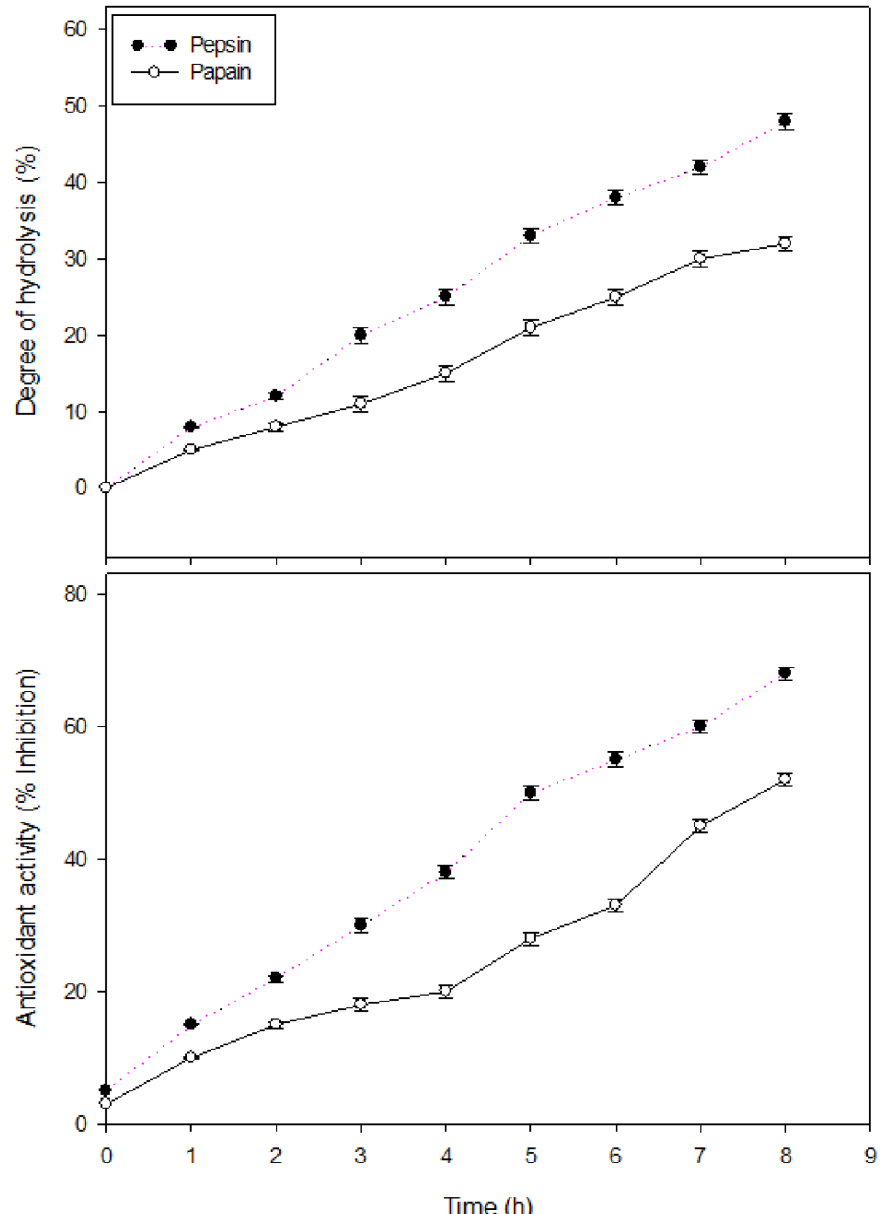
Figure 2. Degree of hydrolysis of pepsin- and papain-whey protein hydrolysates at different times (0–8 h) and antioxidant activity estimated by DPPH assay (% inhibition) at different degrees of hydrolysis. Table 2. Free amino acids (g/100g total free amino acids) of pepsin (PEH) and papain (PAH) whey protein hydrolysate.